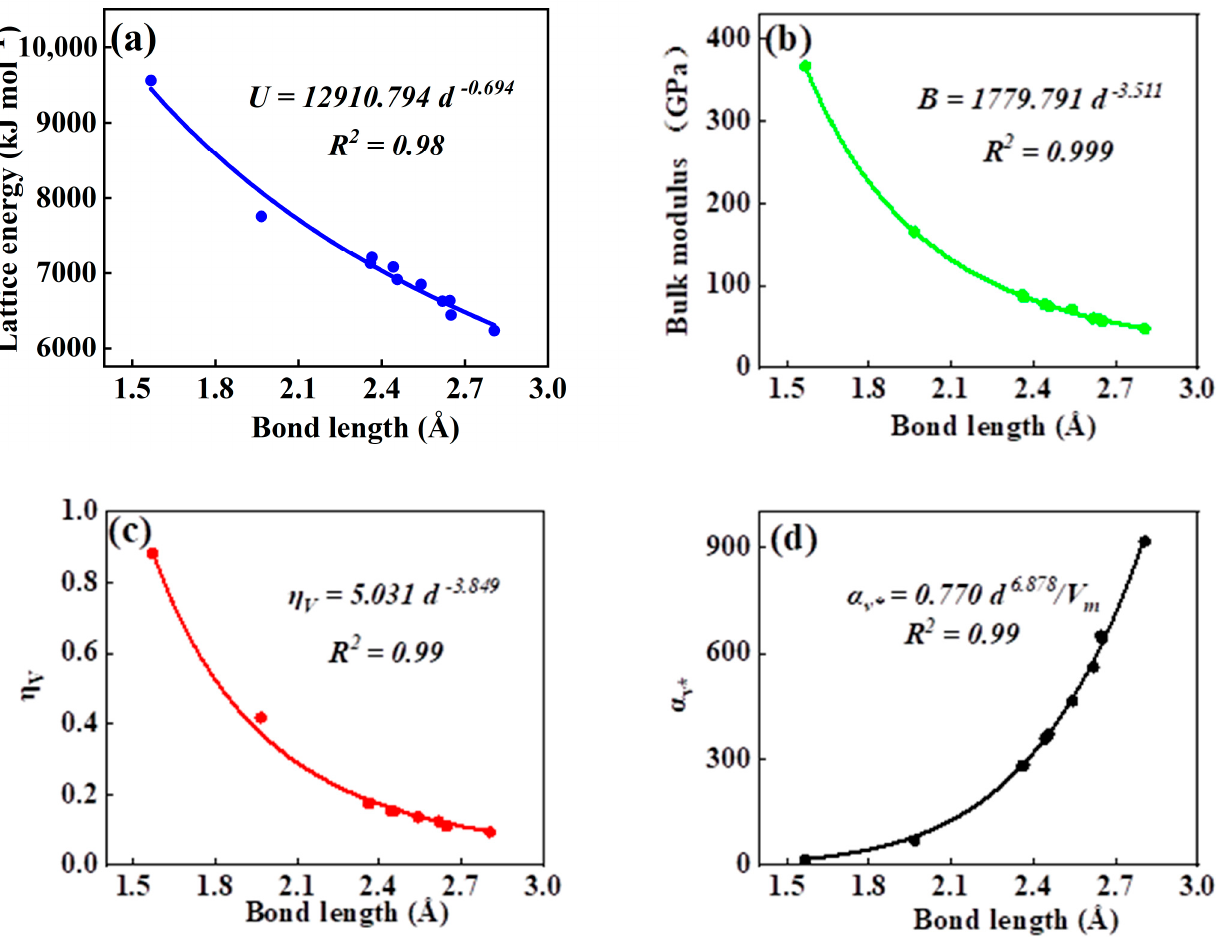
Figure 4. Plot of correlation between the lattice energy, ( a ) bulk modulus, ( b ) chemical hardness density, ( c ) product of electronic polarizability and molar volume, ( d ) and chemical bond length of tetrahedral coordinated crystals of group Ⅱ – Ⅵ .